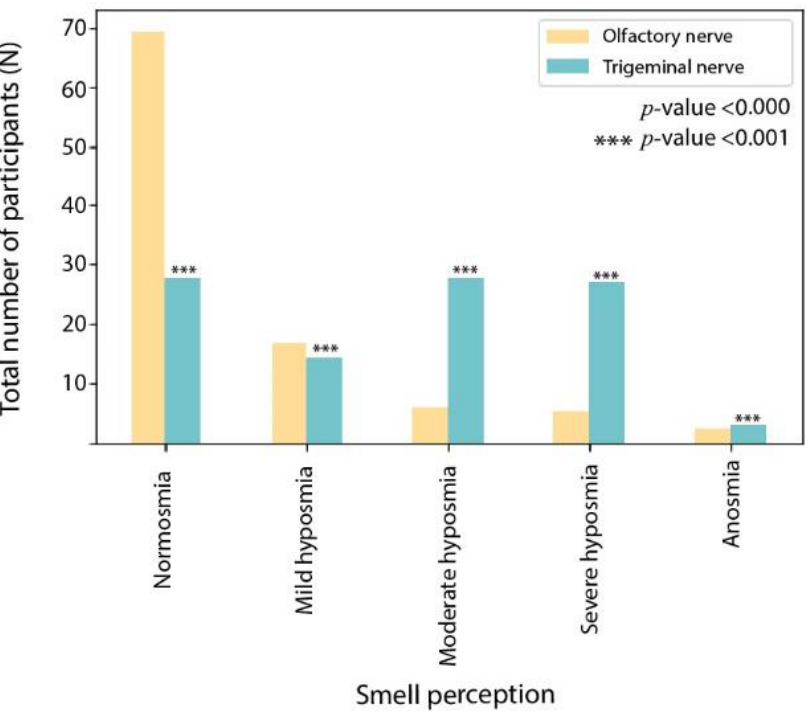
Figure 2. The sensory tests of the olfactory and trigeminal ability.